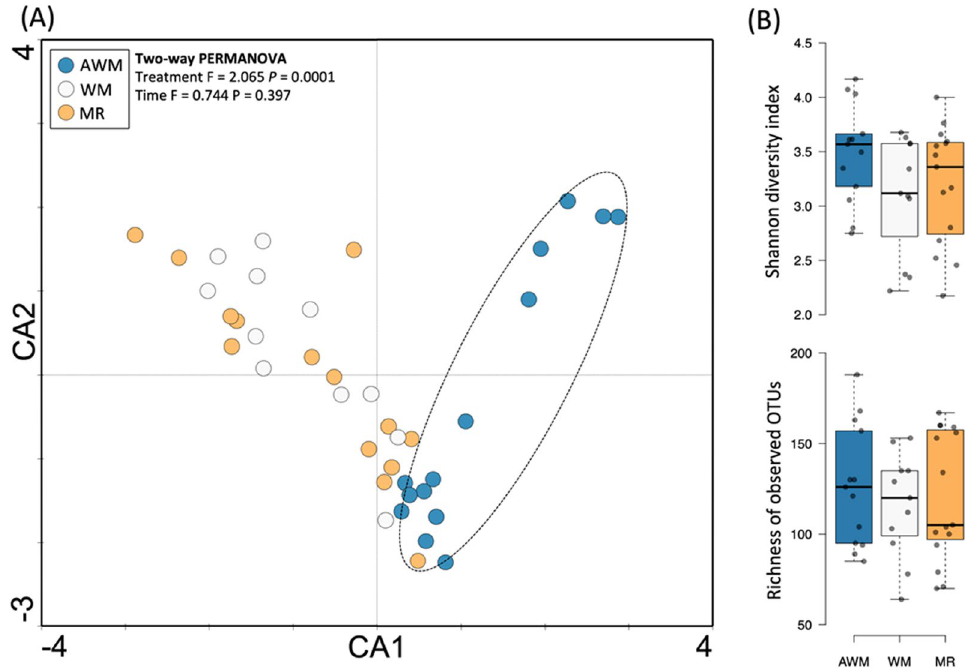
Figure 3. Structure and microbial diversity in diarrheal fecal samples from dairy calves fed different liquid diets. ( A ) Correspondence analysis (CA); ( B ) diversity indexes, Shannon and Richness.